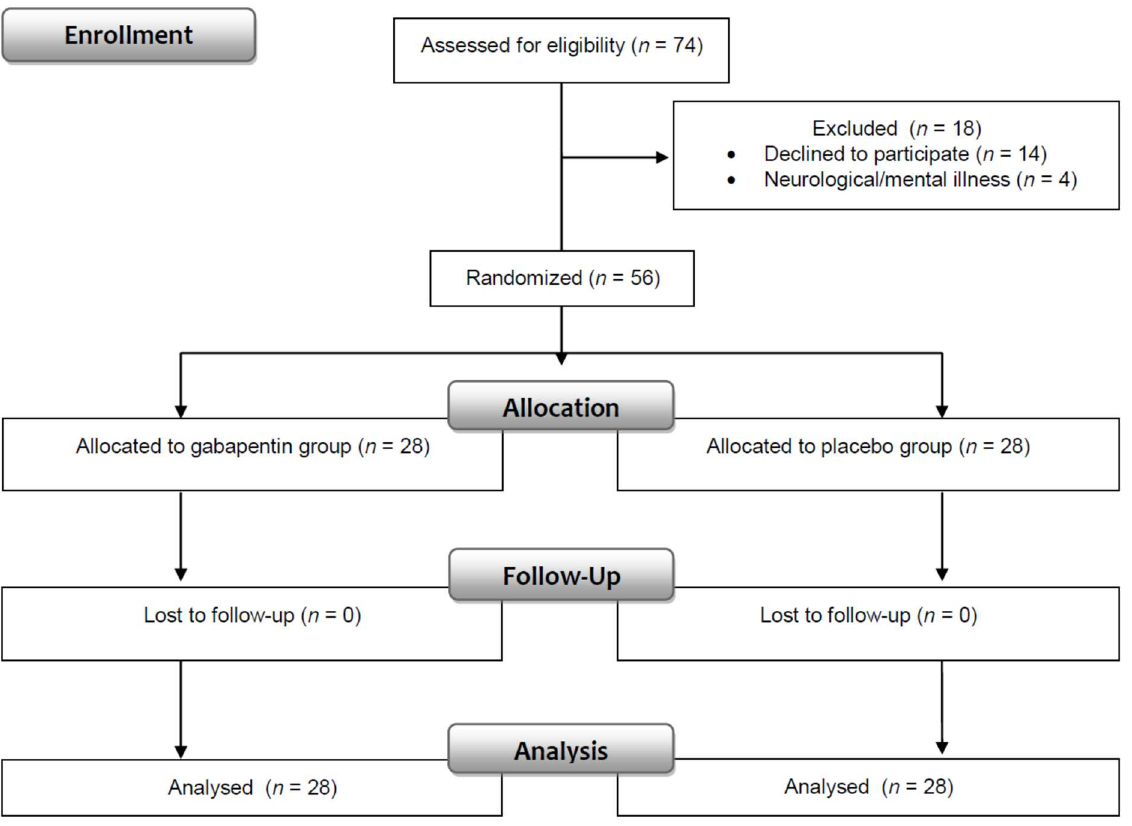
Figure 2. Consort flow diagram.